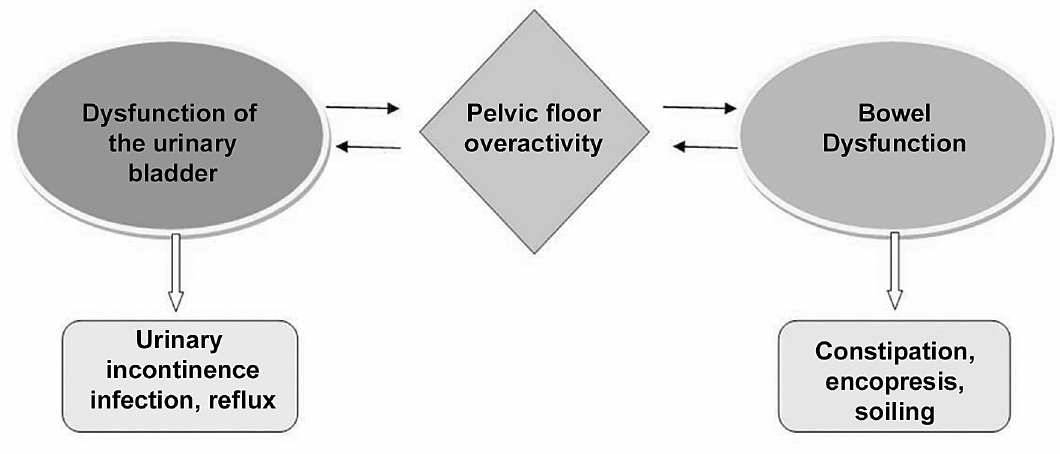
Figure 1 – Overactivity of pelvic floor muscles following bladder and bowel dysfunction * * Modified according to De Paepe et al.